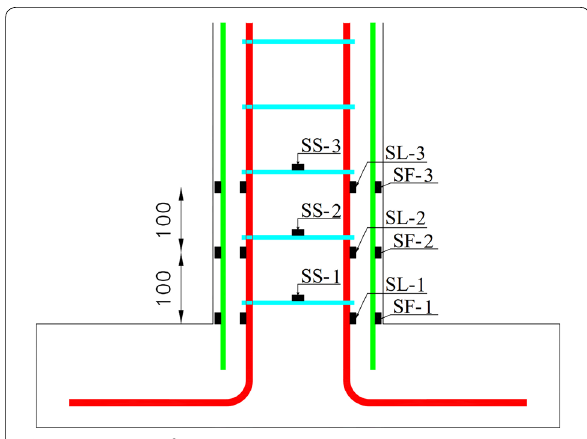
Fig. 3 Locations of strain gauges.